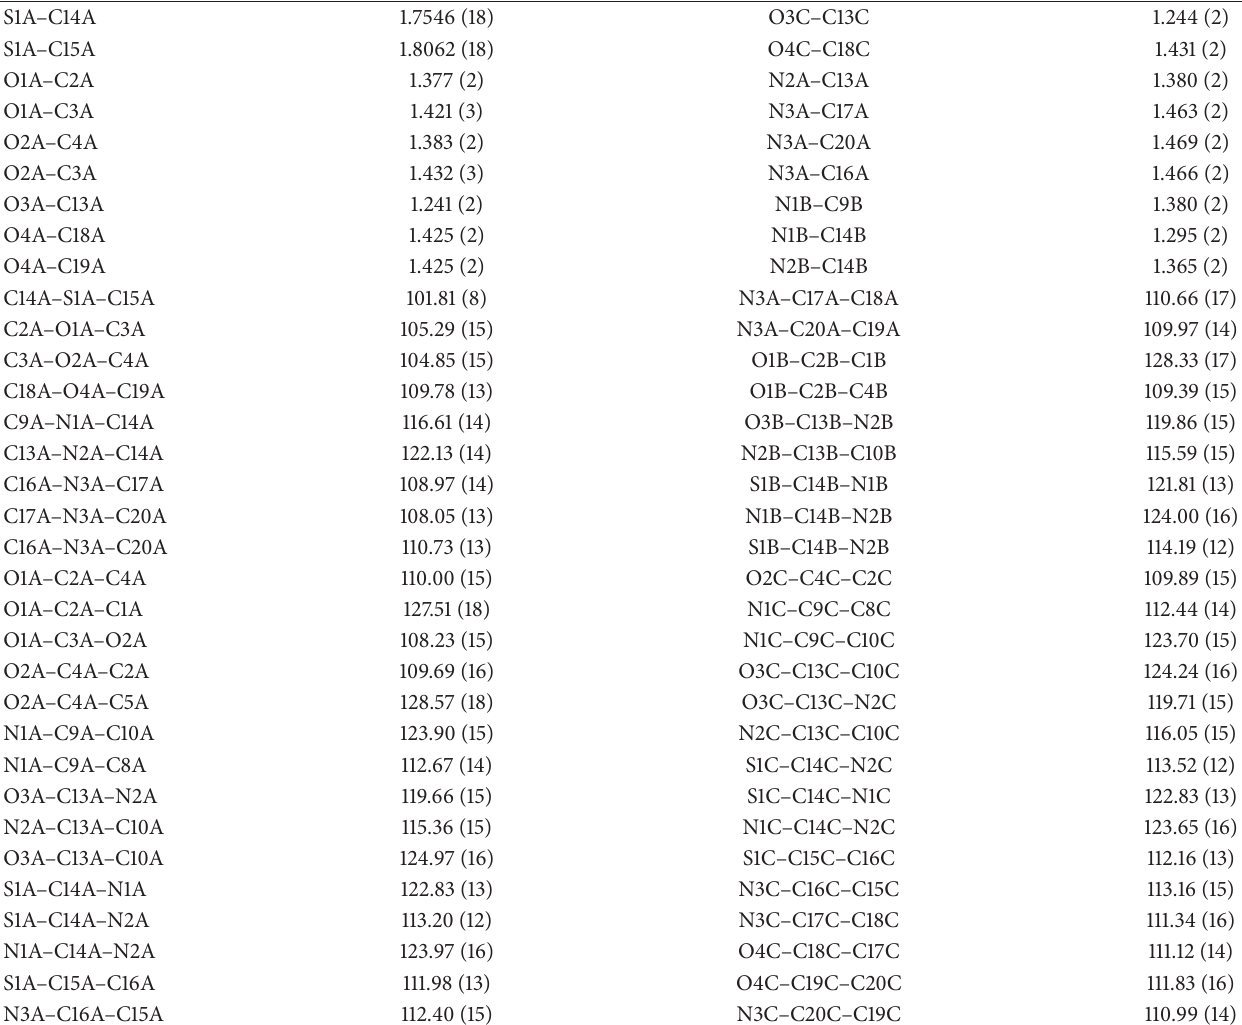
Table 3: Selected geometric parameters (˚A, ∘ ) for one molecule.